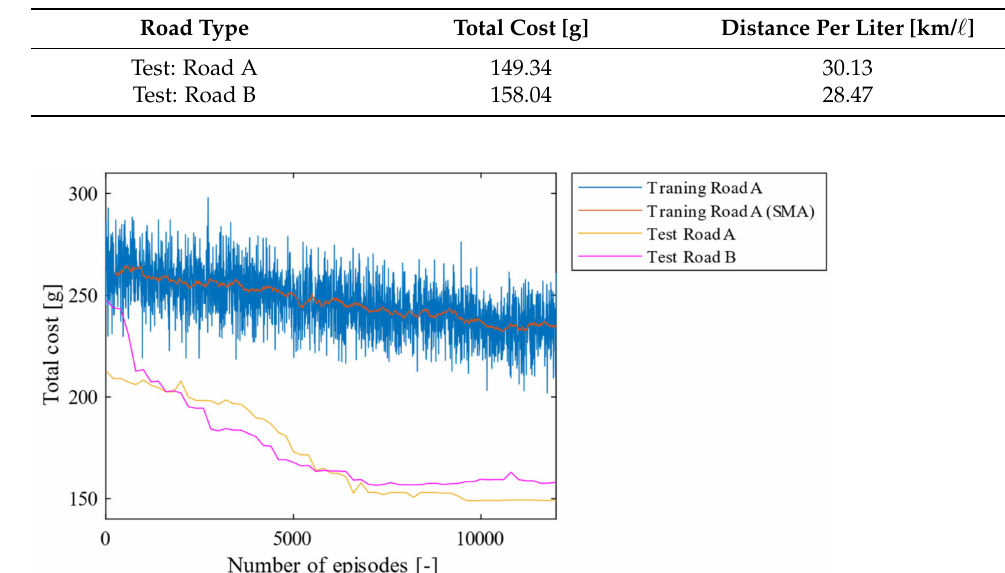
Figure 9. Total cost transition for each episode for the training/testing data by the proposed method. (SMA: Simple Moving